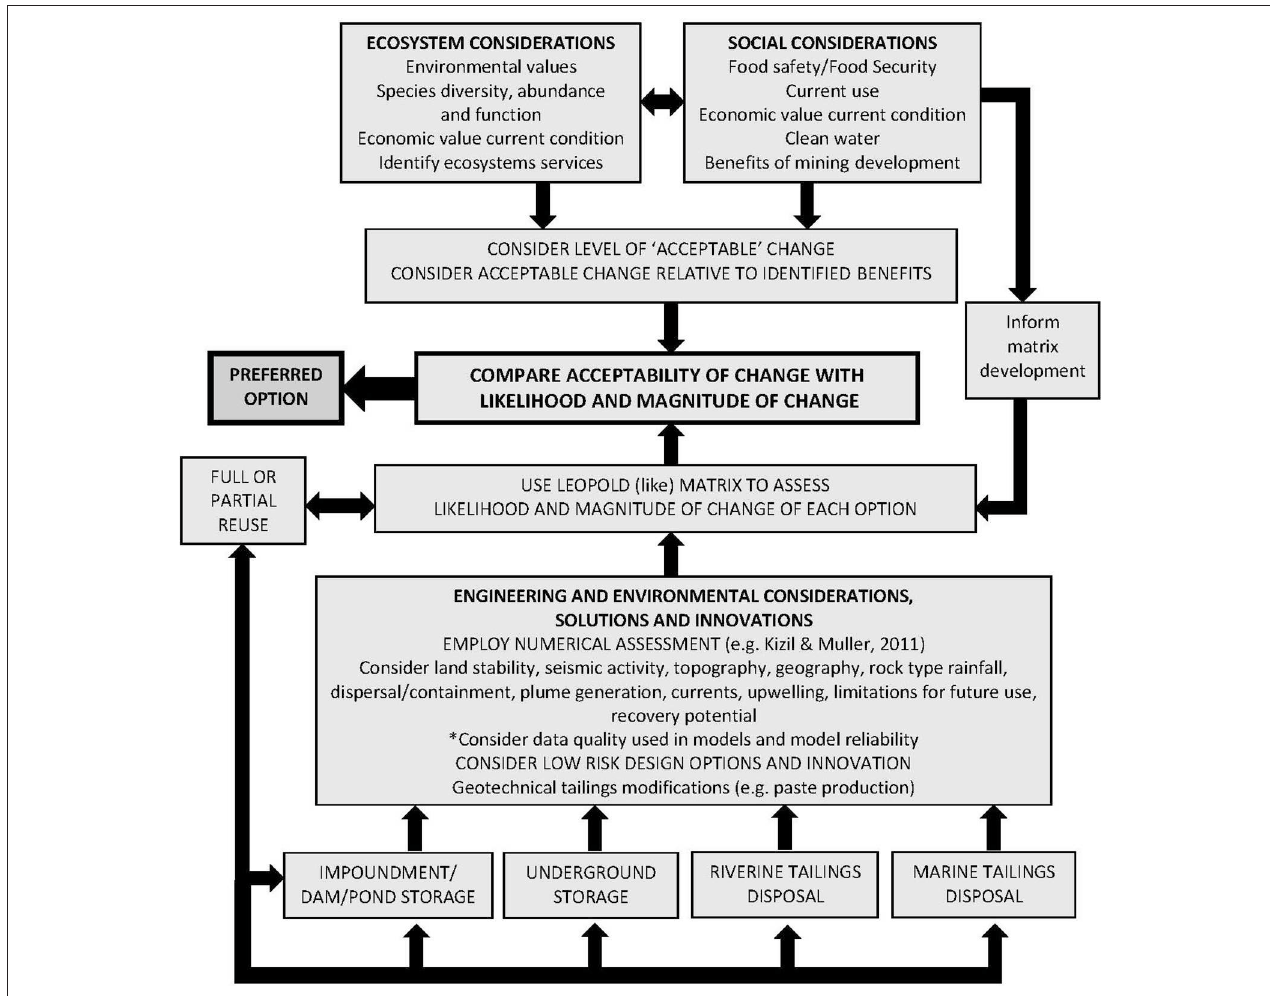
FIGURE 2 | Possible framework for considering options for tailings